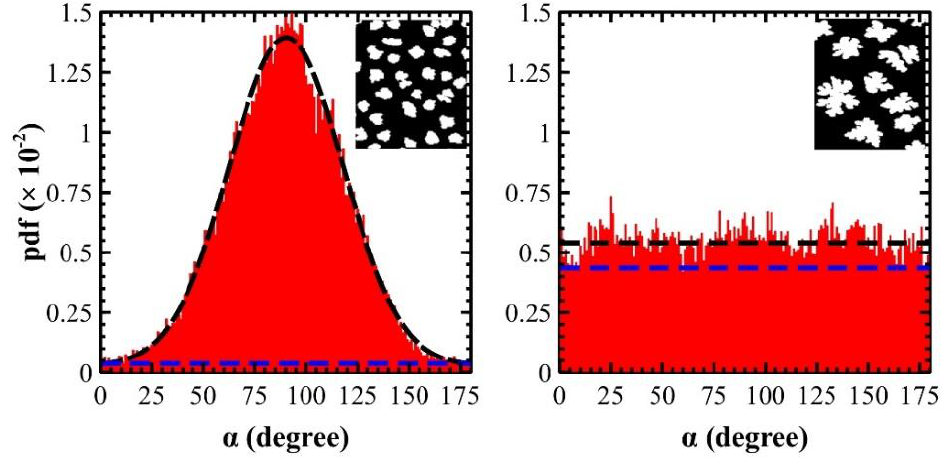
Figure 5. Illustrative pdf plots for compact ( left ) and dendritic ( right ) islands grown at 50 °C. The former is formed at the early stage of the growth ( Θ = 0.28 ML), the latter at the first deposition step after the first ML ( Θ = 1.29 ML). Both curves have a constant baseline of 0.00028 and 0.0045 (dashed blue lines) for compact and dendritic islands, respectively (see inset images). At 25 °C, Gaussian curve perfectly fits the pdf (dashed black lines) while the quasi -rectangular distribution shows a probability fluctuation around 0.0055.